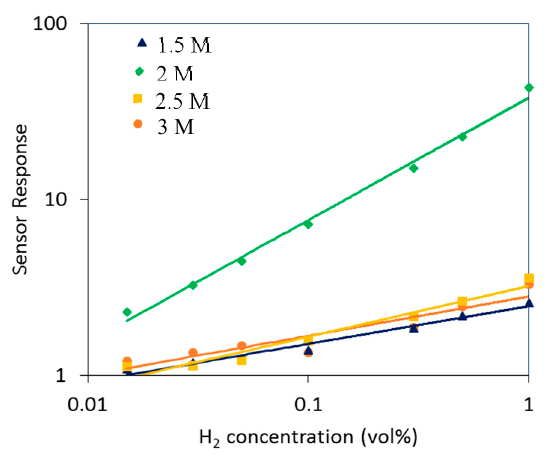
Figure 4. Response vs. H 2 concentration of 2D WO 3 nanostructures prepared by anodization with different HNO 3 concentrations at 350